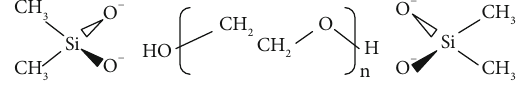
Figure 5: Reaction between PEG and NS.